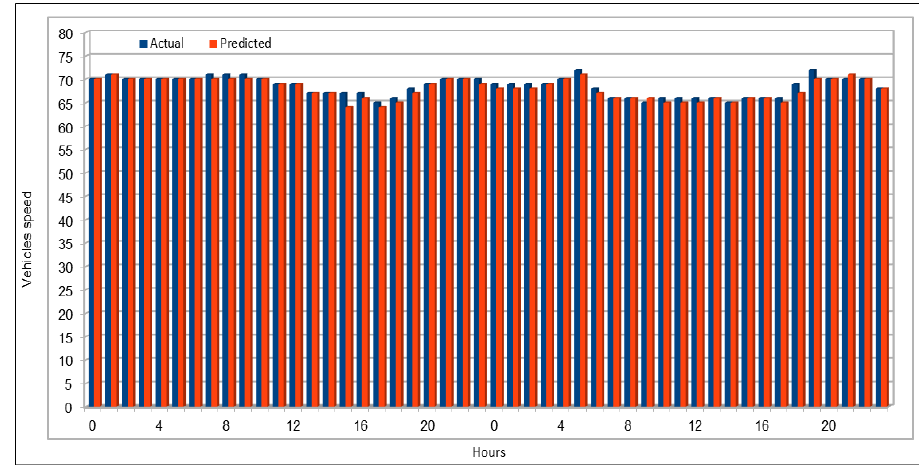
Figure 9. Traffic speed: Actual and predicted values for a single